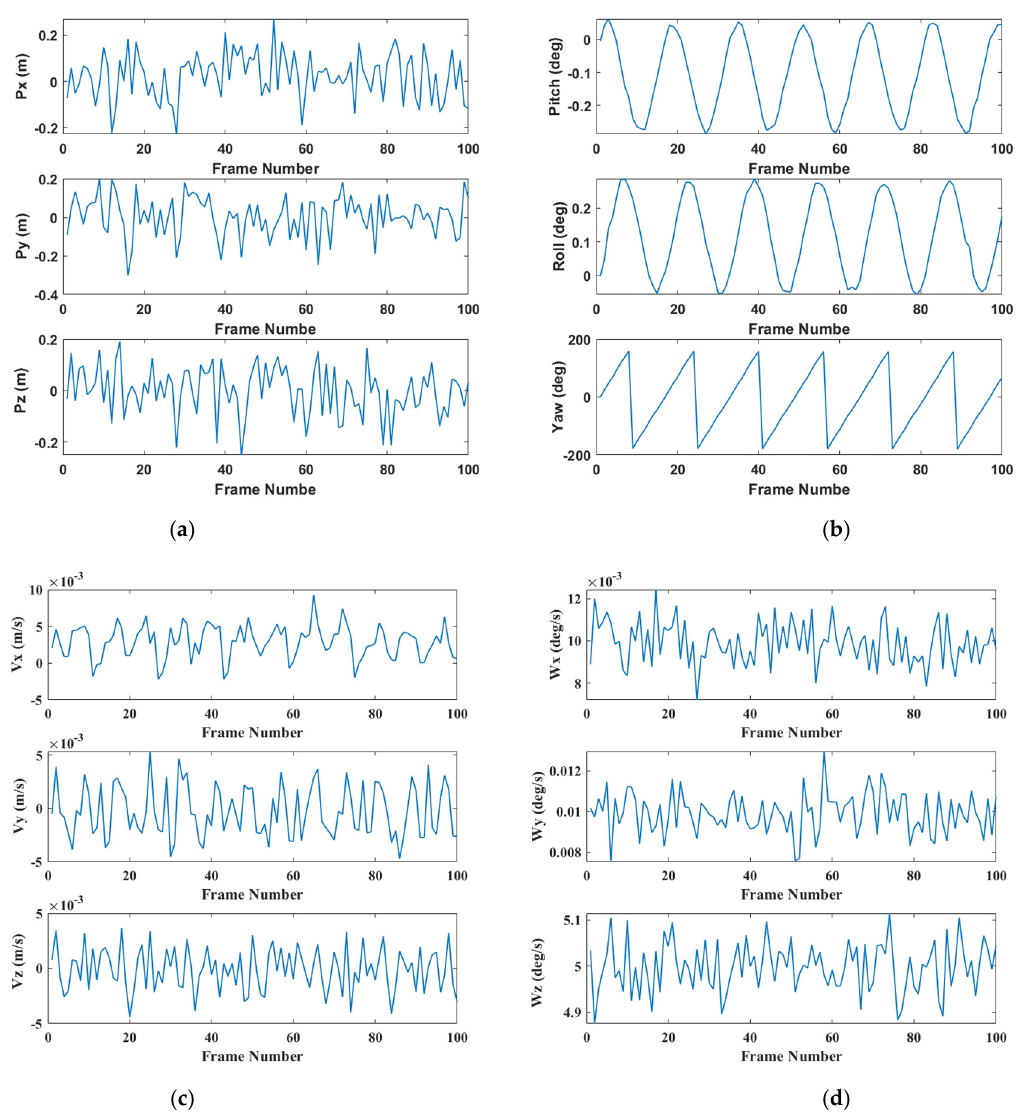
Figure 13. Non-cooperative target pose estimation results of our method: ( a ) translational position, ( b ) rotational position, ( c ) velocity, and ( d ) angular velocity estimation results.